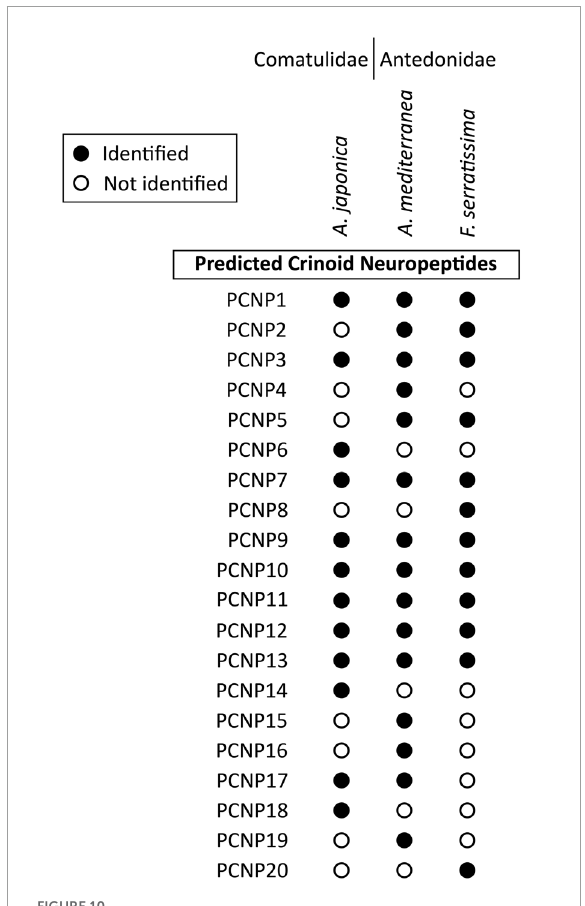
FIGURE10 Summary showing the species in which the sequences of other predicted crinoid neuropeptide precursors (PCNP) have been identified in this study. Filled circles represent cases where neuropeptide precursors were identified in a given species, whereas empty circles represent cases in which the precursors were not identified. The DNA sequences of transcripts encoding these precursors are shown in Supplementary File 2 . Multiple sequence alignments of PCNP sequences from the three crinoid species are shown in Supplementary File 3